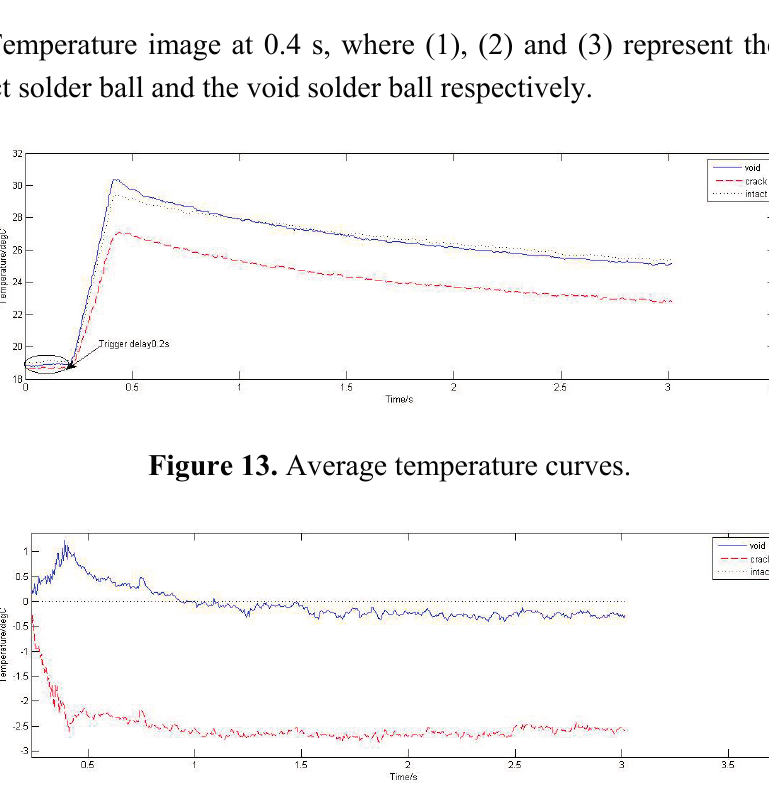
Figure 14. Temperature difference